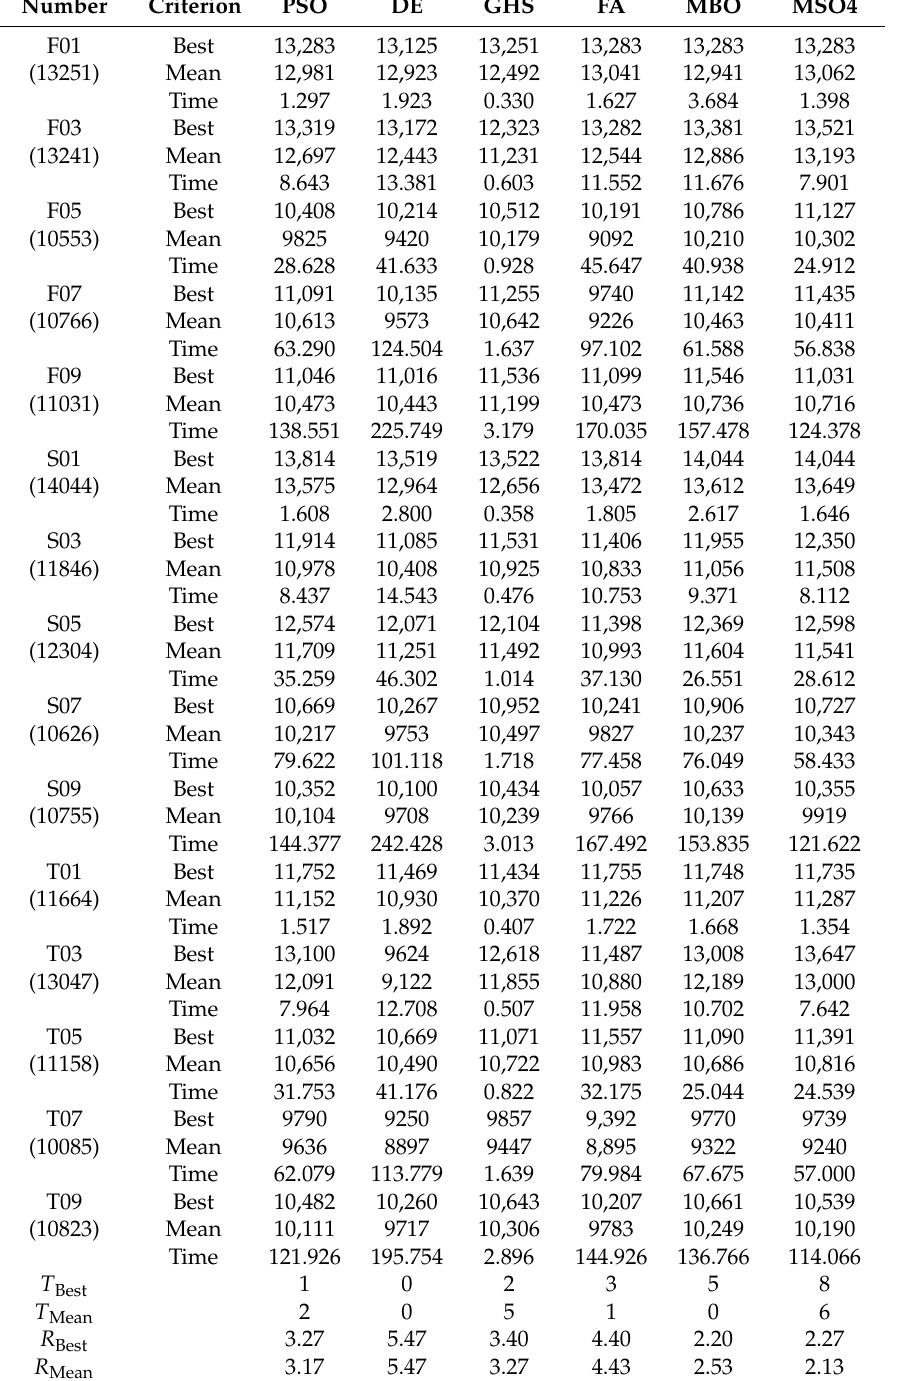
Table 8. Computational results and comparisons on the Best and Mean on 15 SUKP